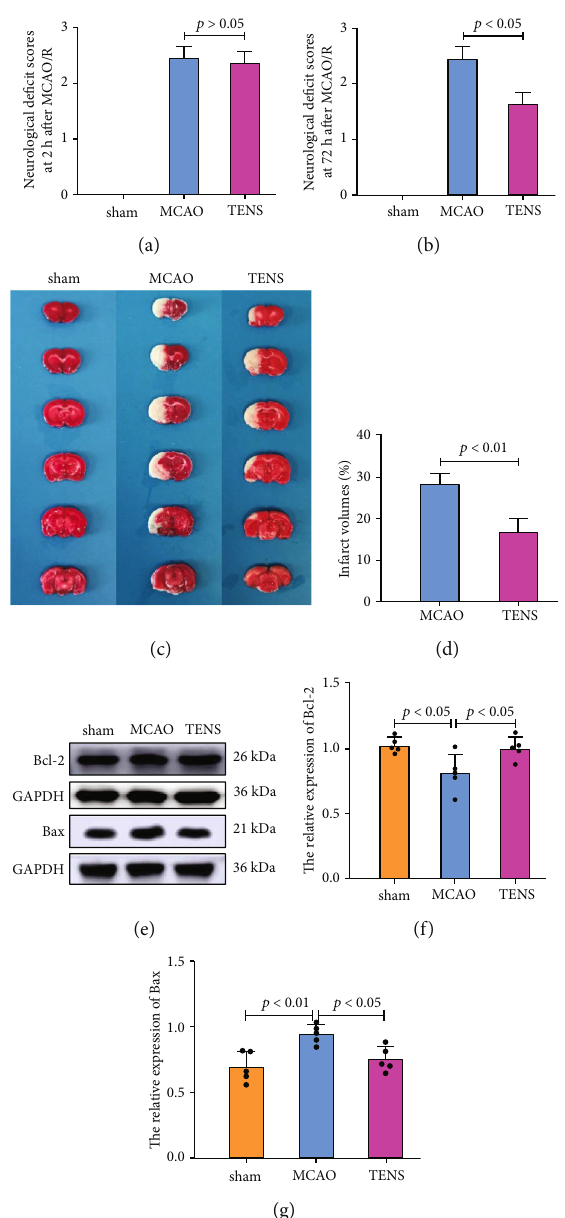
Figure 2: The pathological damage after cerebral ischemia/reperfusion (I/R) within 3 days. (a) Statistical analysis of neurological de fi cit score assessment at 2h after MCAO/R injury. (b) Statistical analysis of neurological de fi cit score assessment at 72 h after MCAO/R injury. (c) The 2,3,5-triphenyltetrazolium chloride (TTC) staining demonstrating infarct volumes in MCAO rats with or without TENS. (d) Statistical analysis showing TENS signi fi cantly reduced neural damage when compared with the MCAO group. (e) Western blot analysis of the expression levels of Bcl-2 and Bax (GAPDH was used for the loading controls). (f, g) Statistical analysis showing the Bcl-2 and Bax expression in the injured hippocampus among three